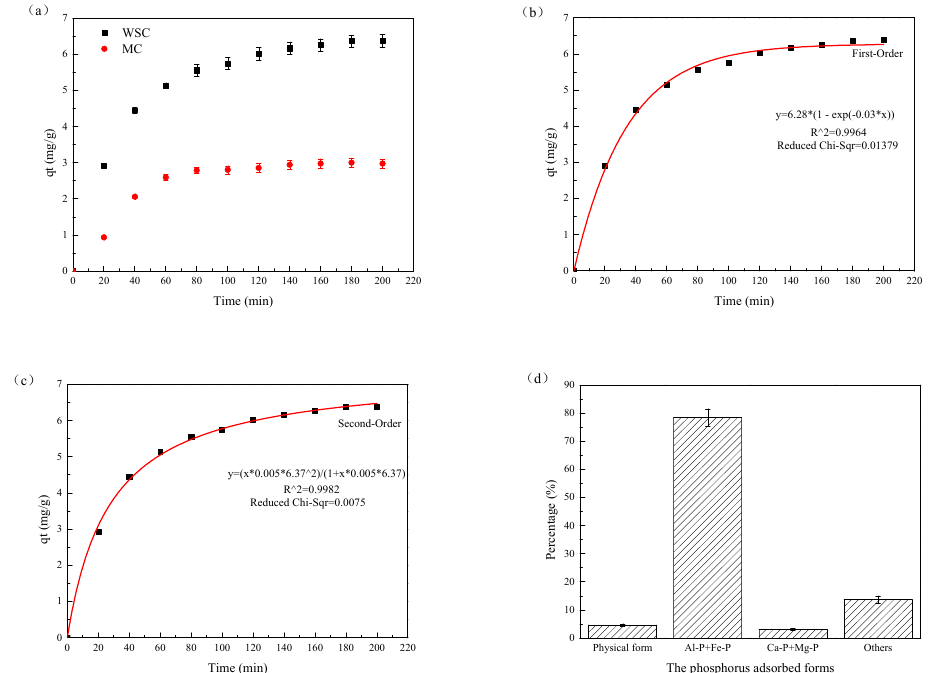
Figure 3. ( a ) P absorption efficiency of waterworks sludge ceramsite; ( b ) Pseudo-first-order model describing P adsorption; ( c ) Pseudo-second-order model describing P adsorption; ( d ) Adsorbed forms of P by waterworks sludge ceramsite.